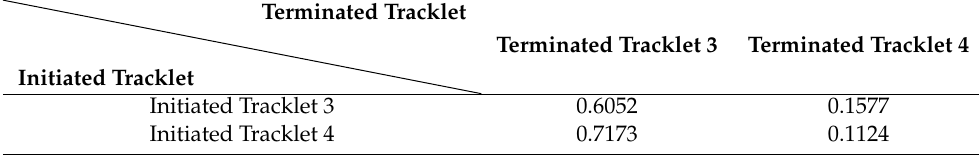
Table 3. Association costs between tracklet pairs of target 3 and target 4.